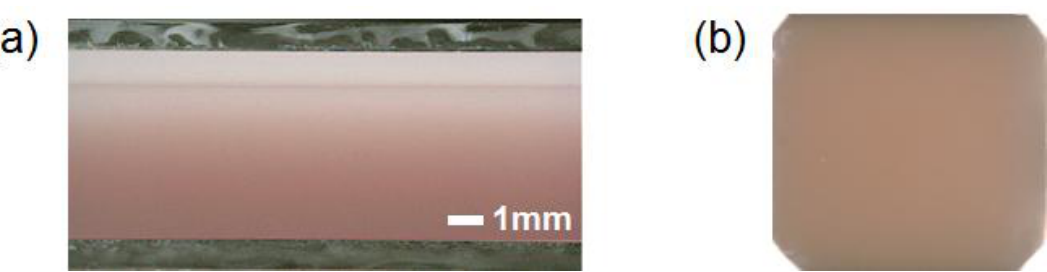
Figure 3. Photographs of tissue-like agar gel phantom for ( a ) cross-sectional view and ( b ) top